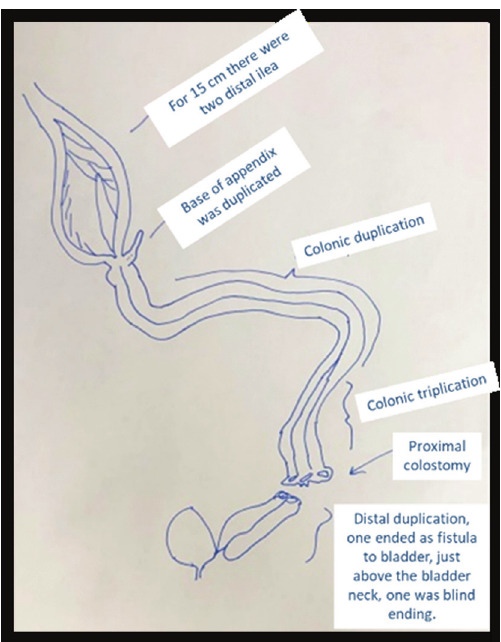
Fig. 3 Diagram of the operative fi ndings.